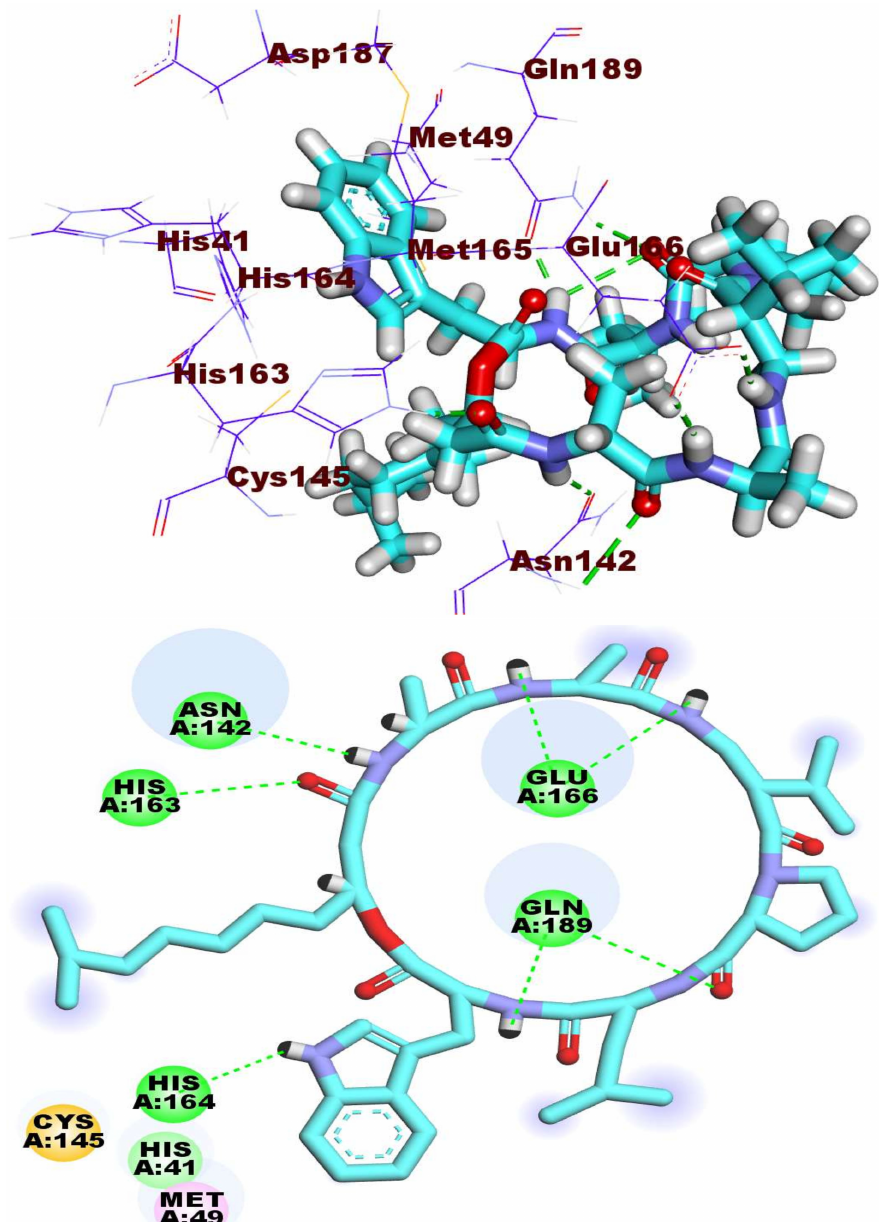
Figure 7. The binding pattern of compound 184 inside the M pro PDB ID: 6LU7 active site. The antiviral compound 278 exhibited a ∆ G of − 29.00 kcal. mol − 1 . It was combined with receptor protein through five hydrogen bonds and four hydrophobic interactions as shown in Figure 8. Basically, the 7-hydroxy-5,9-dimethyl-6 H -naphtho [2,1- d ][1,3]dioxin -6- one occupied the first pocket of COVID-19 main protease with two hydrophobic interactions with Pro168 and Ala191. The macrocyclic structure of the tested compounds occupied the other three pockets of the target receptor engaging in five hydrogen bonds with Glu166, His164, Cys145, Gly143, and Gln189. Moreover, it formed two hydrophobic interactions with Met165 and